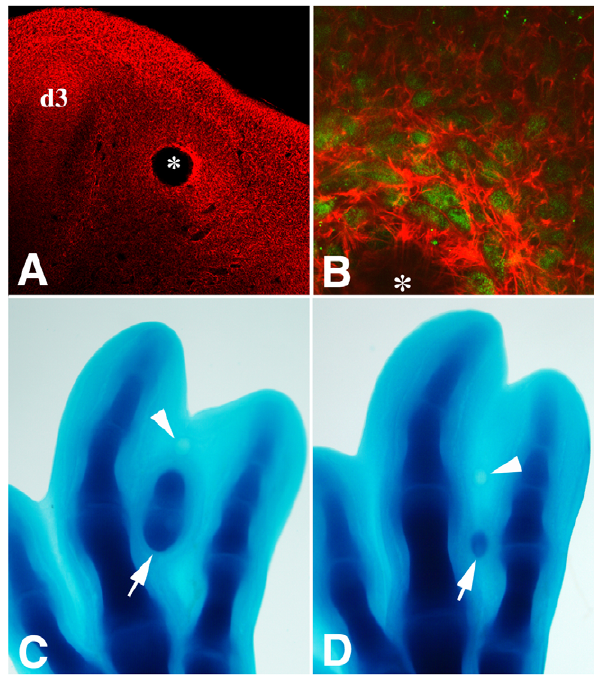
Figure 2. Actin cytoskeleton in digit chondrogenic induction. A, Low magnification view of a phalloidin-stained section of the autopod at 3 hr ABI to show increased staining around the bead (*) and at the digit tip of neighboring digit 3 (d3). B, Detailed view of the actin cytoskeleton of p-Smad2-positive (green nuclear labeling) cells located around the Tgf b bead (*) 3 hr ABI. Note the increased protrusive actin- based filaments in the p-Smad2-positive cells. Digit 3 (d3), digit4 (d4). C–D, Morphology of the ectopic cartilage (arrows), 2 days after combined treatment with a Tgf b bead and a Cytochalasin D bead (experimental, D) or a DMSO bead (control, C). Cytochalasin D (D) and DMSO (C) beads are indicated by arrowheads.